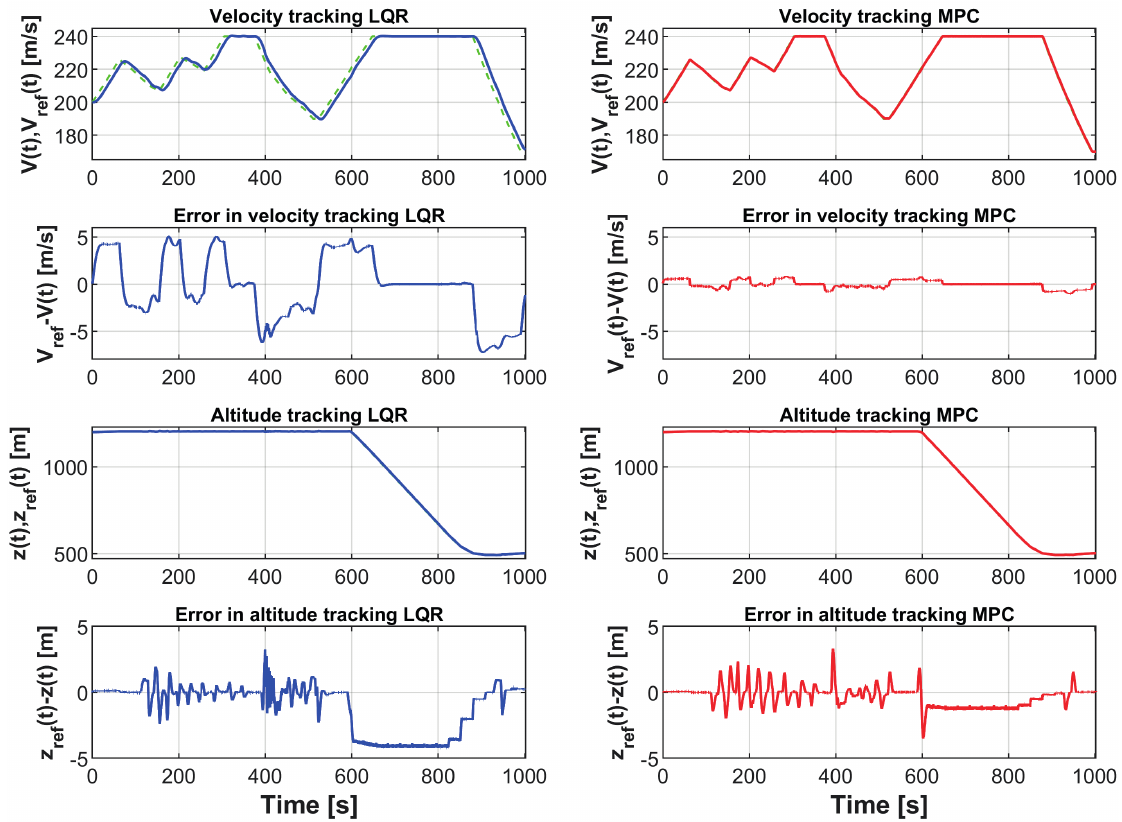
Figure 10. Reference tracking of velocity and altitude: linear quadratic regulator (LQR) (blue), MPC (red), and the reference for each case (discontinuous